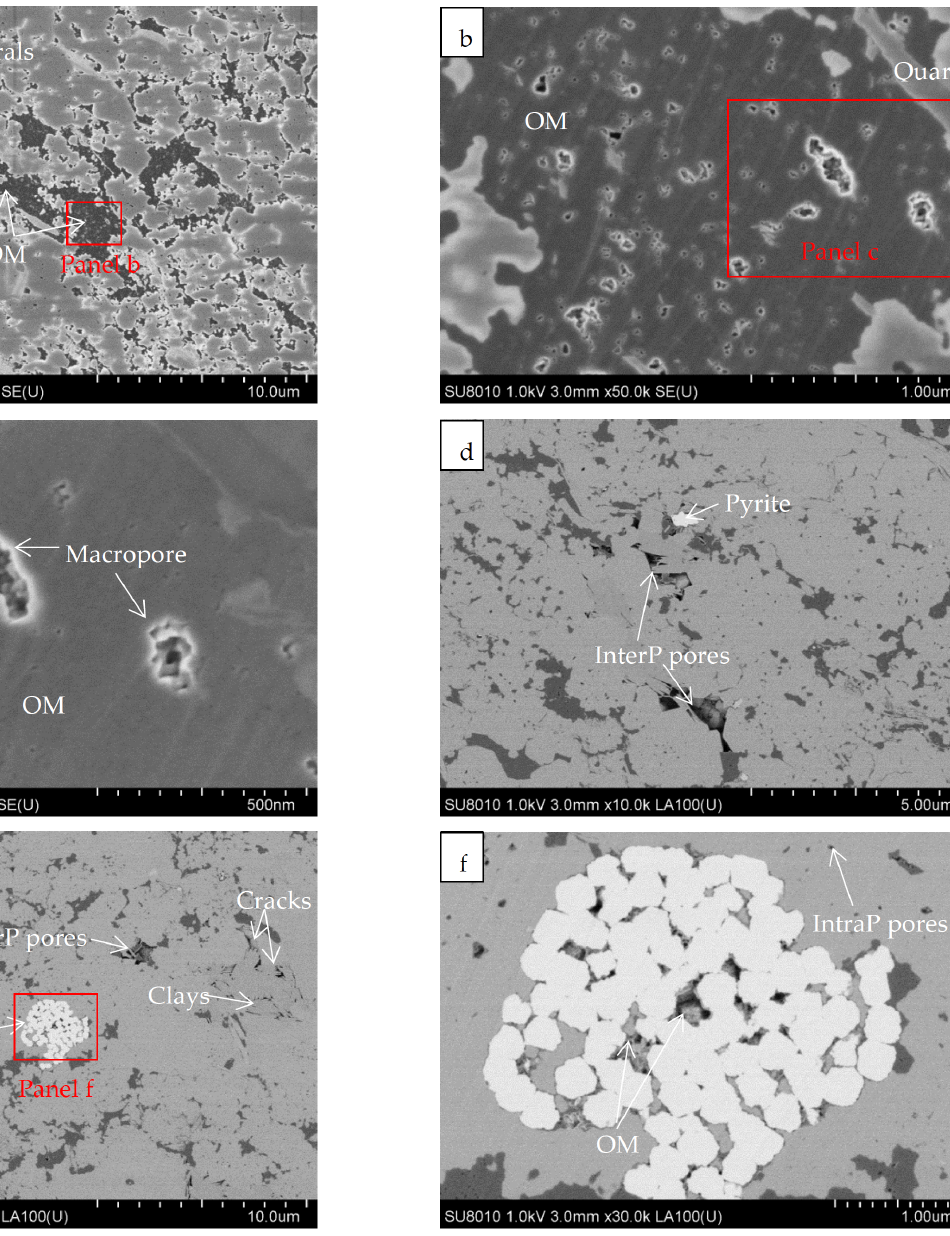
Figure 7. ( a – f ), FE-SEM images of the organic-rich Permian shale (Sample C1-7, TOC = 11.8%) with type III kerogen from the Lower Yangtze area. OM = organic matter; InterP pores = inter-particle pores; IntraP pores = intra-particle pores. (( a , d , e ), Minerals; ( a – c ), OM pores; ( d – f ), Pyrite; ( d , e ), InterP pores; ( f ), IntraP pores).